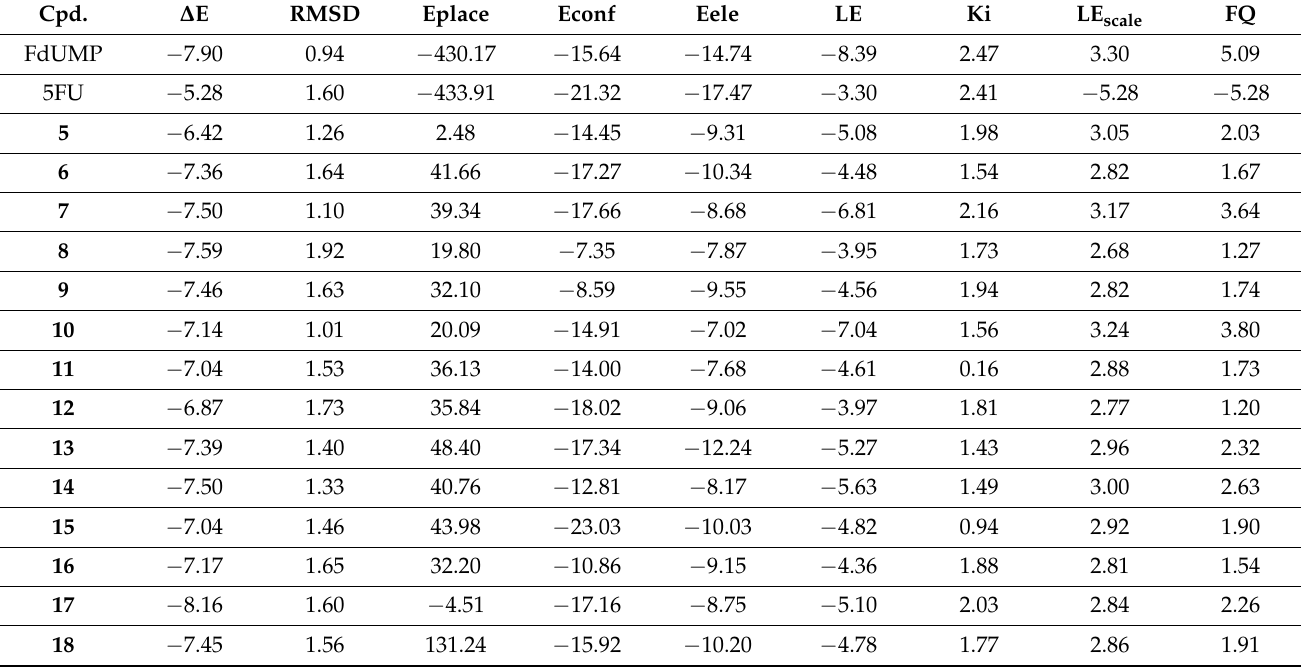
Table 6. Docking energy in (kcal/mol) and bioactivity analysis parameters against 6QXG.